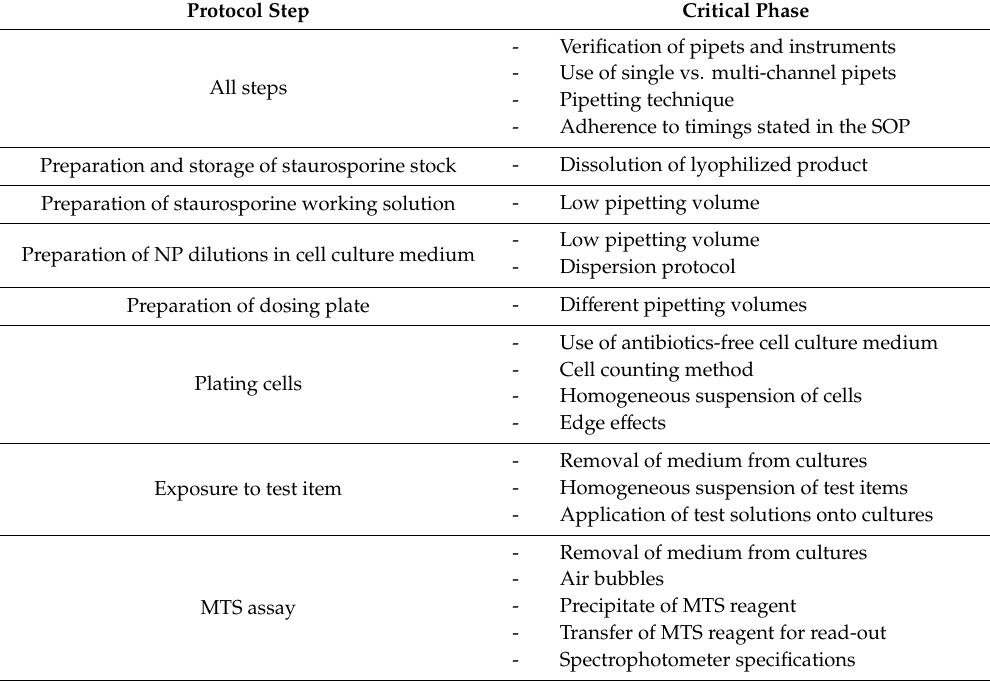
Table 2. Critical steps in the standard operating procedure (SOP) for the MTS cytotoxicity assay. Following the analysis of the first data obtained for cells treated with staurosporine, PS-NH2 and PS-COOH, and the collection of responses of the participating laboratories to an online questionnaire on SOP interpretation and test performance, sensitive steps in the SOP that could generate and explain the observed variability of outcomes have been